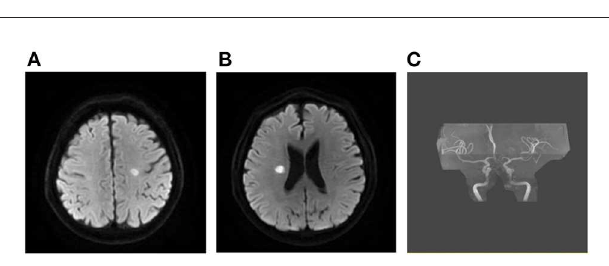
FIGURE6 DWI of patients with cerebral small vessel disease. A 51-year-old man had developed left-side central facial palsy, weakness of left limbs, and right hand numbness. MRI showing bilateral supra-tentorial ischemic lesions (A, B) . MRA did not show obvious large artery stenosis (C) , and no other etiology was found. DWI, diffusion-weighted imaging; MRI, magnetic resonance imaging; MRA, magnetic resonance